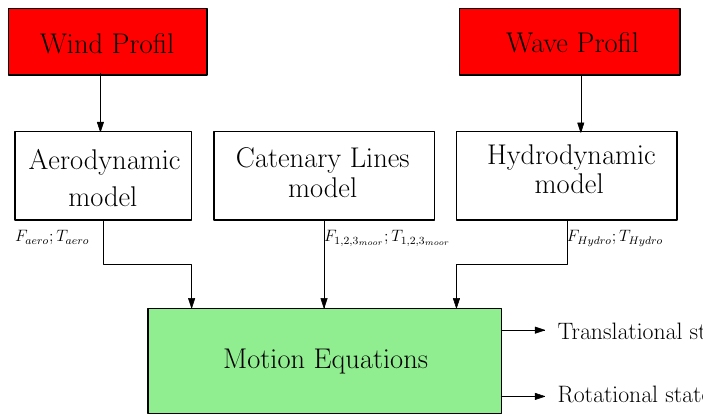
Figure 2. Module scheme of the mechanical structure